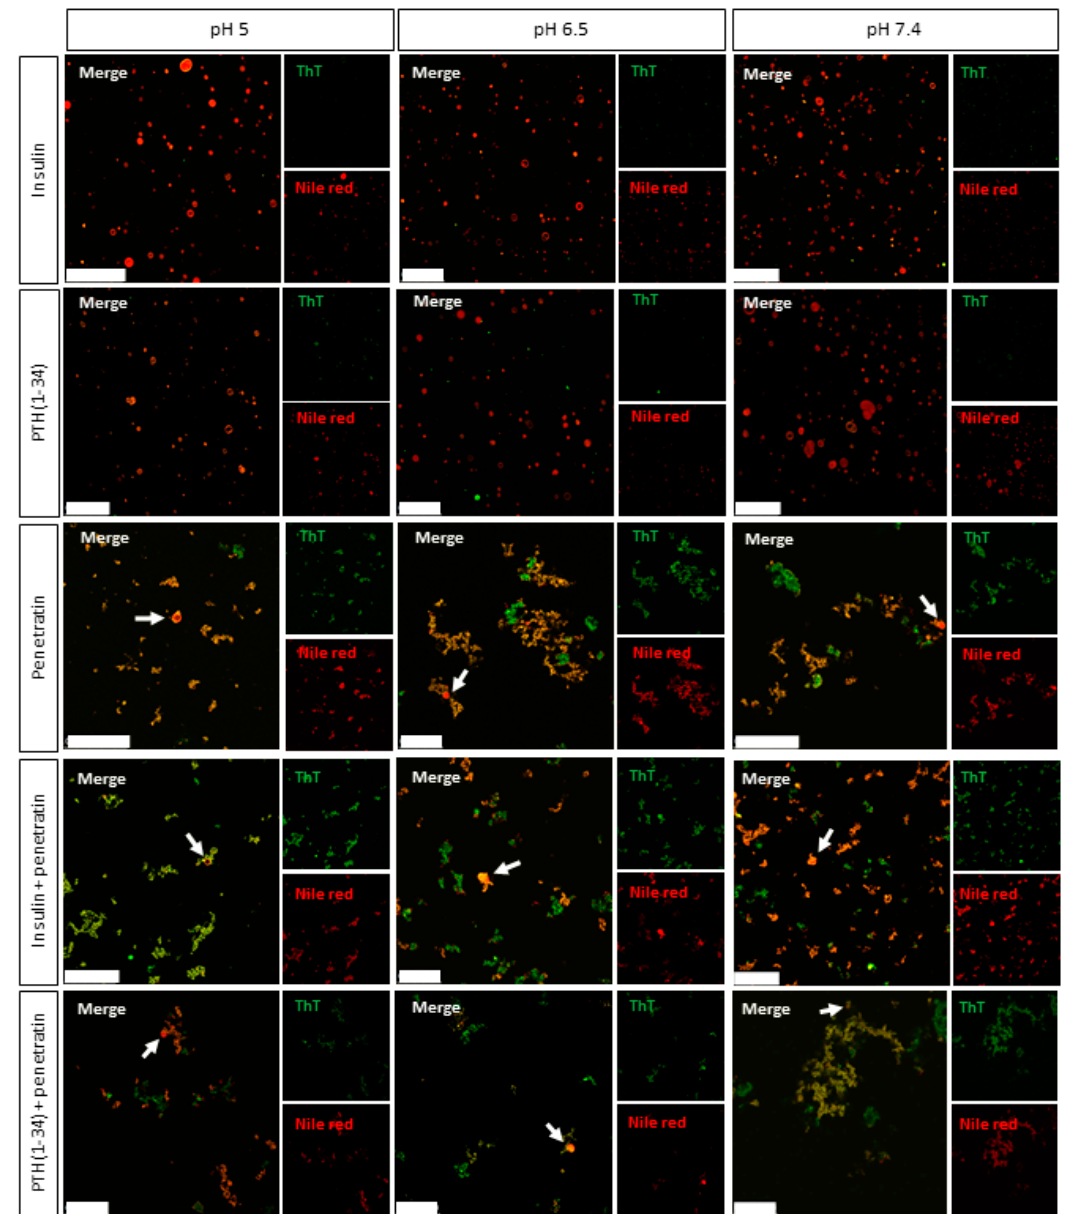
Figure 4. Representative confocal microscopy images of complexes obtained from mixing 50 μ M insulin or PTH(1 ‐ 34) with 200 μ M penetratin at pH 5, 6.5, or 7.4 in the presence of POPC:POPG (80:20 molar ratio) liposomes and Thioflavin T (ThT) (green) and Nile Red (red). Arrow heads: Examples of unruptured liposomes in samples containing penetratin. Scale bars: 50 μ m.